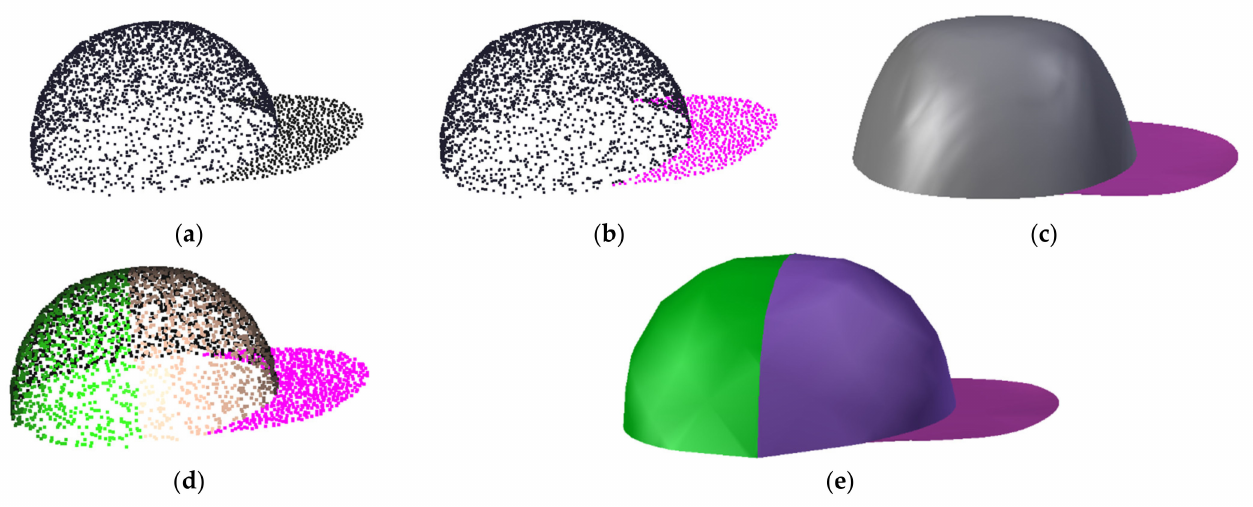
Figure 10. ( a ) The ground truth of a slide surface; ( b ) point set of a slide surface; ( c ) surface recon- structed using Poisson after segmentation; ( d ) PDE-based surface using a single 16-variable PDE model; ( e ) PDE-based surface using a single 64-variable PDE model.